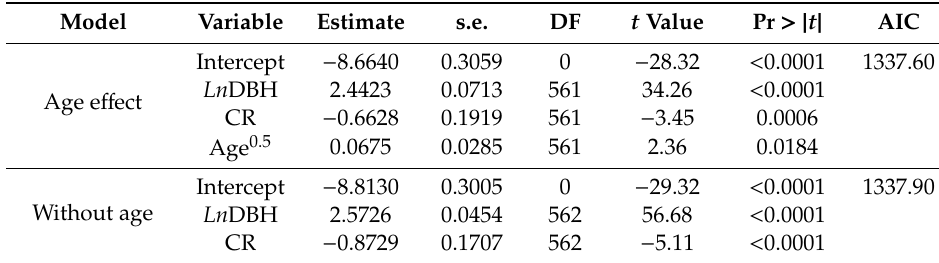
Table 13. Bark thickness (BT) models for redwood trees in multiaged stands. Generalized linear model for the square root-transformed BT (mm) as a function of DBH (mm) and crown ratio, with and without breast-height age (years).